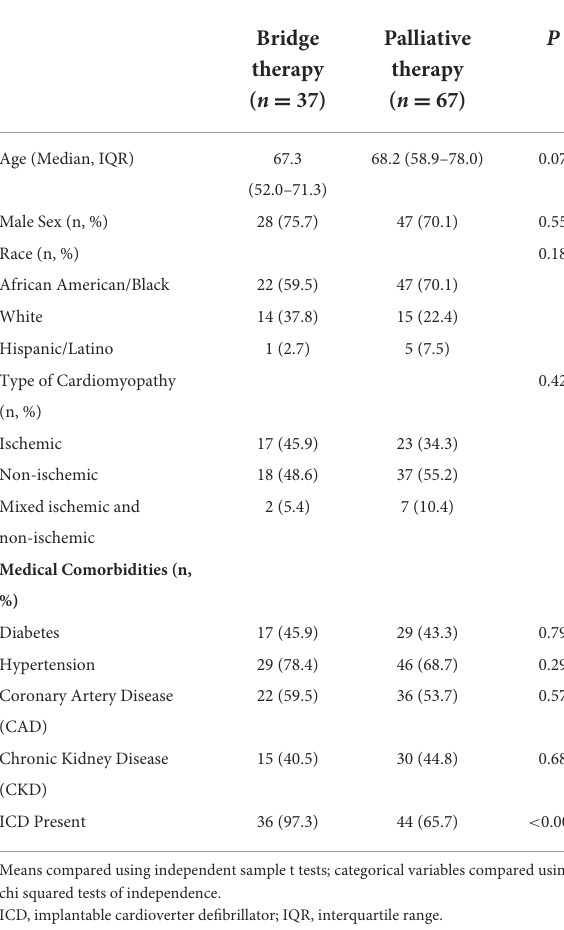
TABLE 1 Patient demographic characteristics stratified by indication of CIIS at initiation.